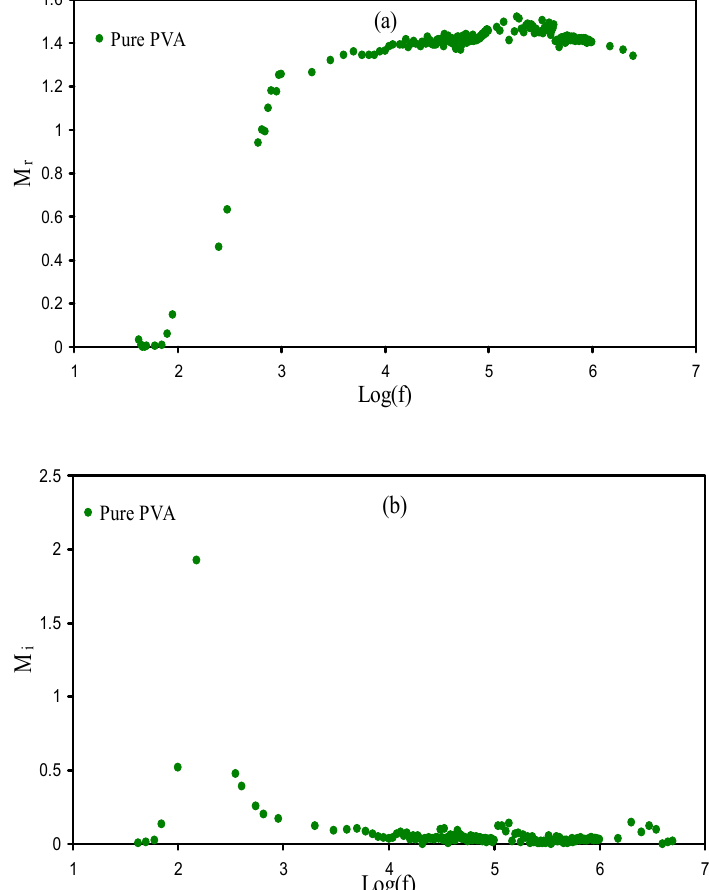
Figure 6. Electric modulus of ( a ) M r v log(f) and ( b ) M i v log(f) for pure PVA film at RT.